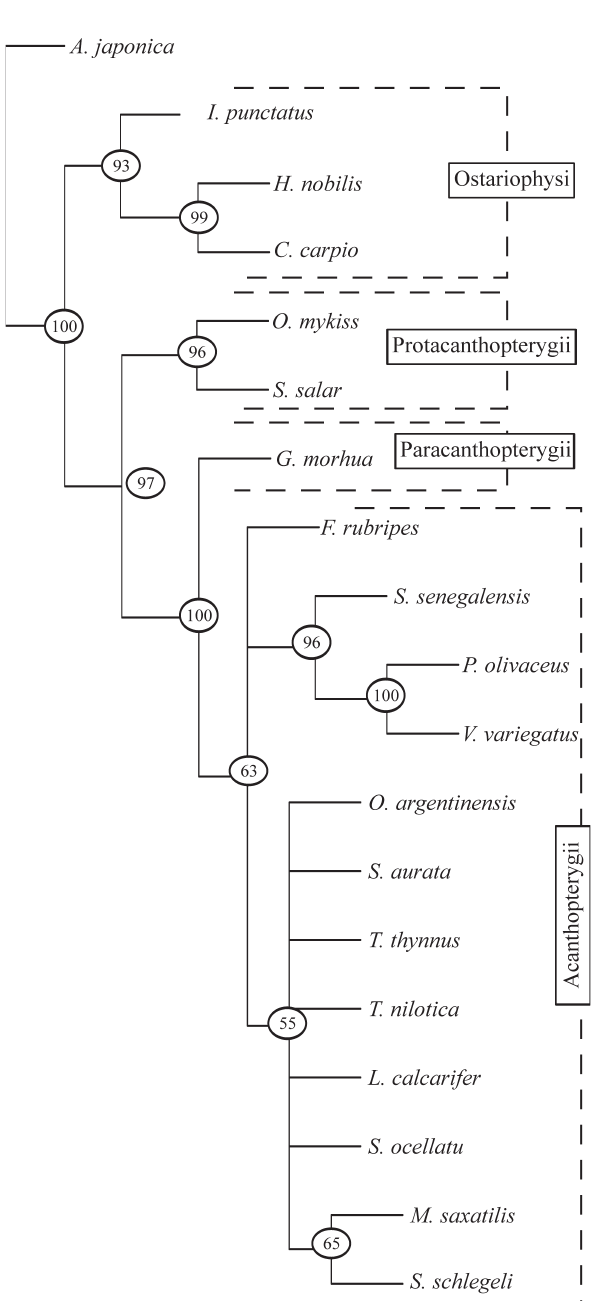
Figure 3 - The strict consensus cladogram (majority rule) of euteleostean GH amino acid sequences using the maximum parsimony method of PHYLIP 3.6. Values at the branch point are the percentage of bootstrap replicates that supported that branch out of 1000